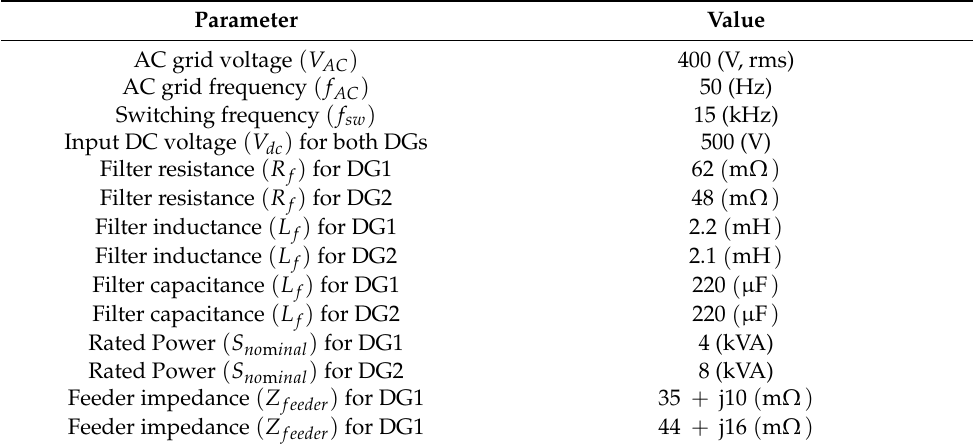
Figure 6. The MG under consideration. Table 1. System specifications.